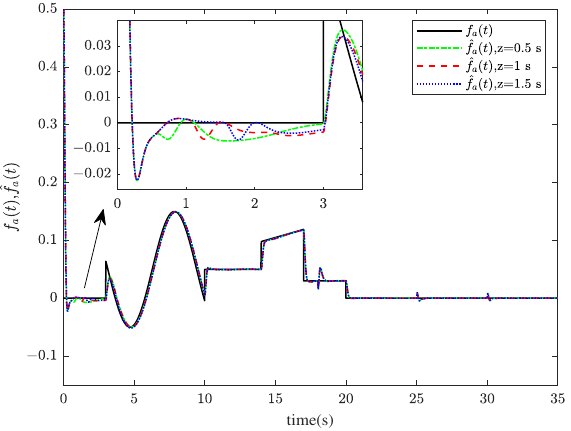
Figure 5. The actuator fault f a ( t ) and its estimation ˆ f a ( t )